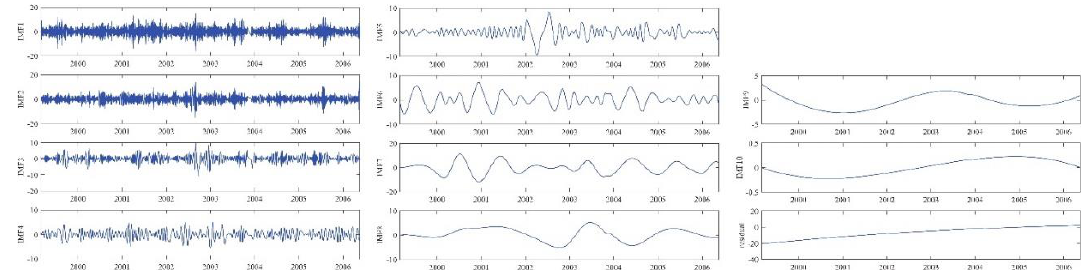
Figure 16. The 𝐼𝑀𝐹𝑠 of BJFS station in U direction from EMD. Figure 16. The IMFs of BJFS station in U direction from EMD.